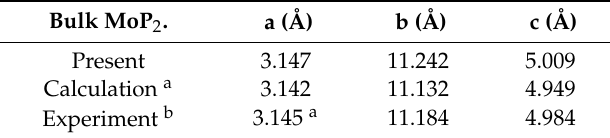
Table 1. The lattice parameters of bulk MoP 2 .